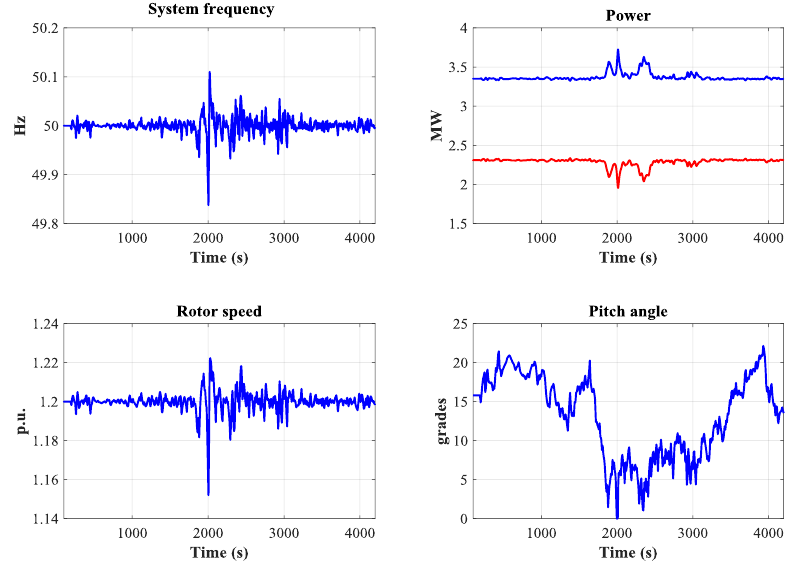
Figure A3. Dynamic responses of the system in case E during wind speed fluctuation.